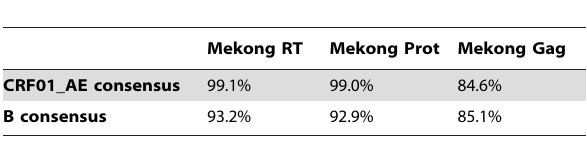
Table 1. Percentage of homology between CRF01_AE Vietnamese consensus sequences of RT, Prot and Gag aligned with the consensus CRF01_AE or B